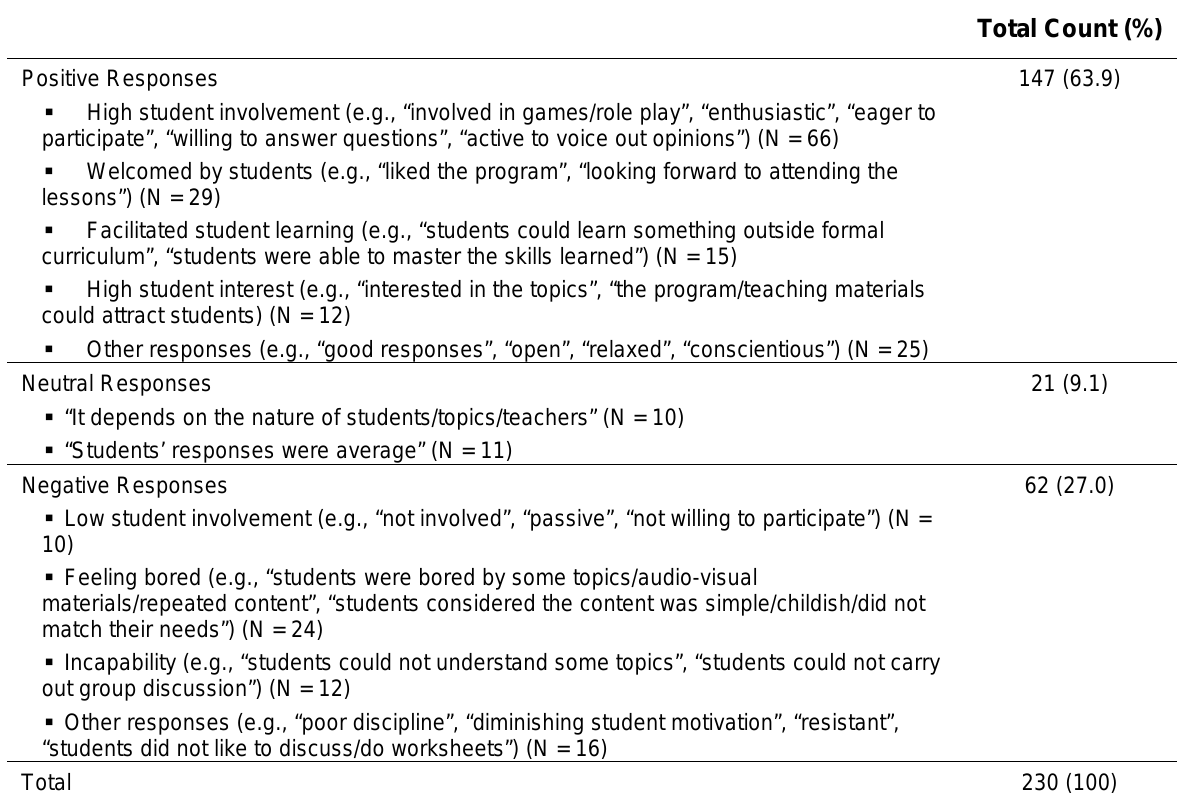
Workers’ Perceptions of the Responses of the Students to the Secondary 1